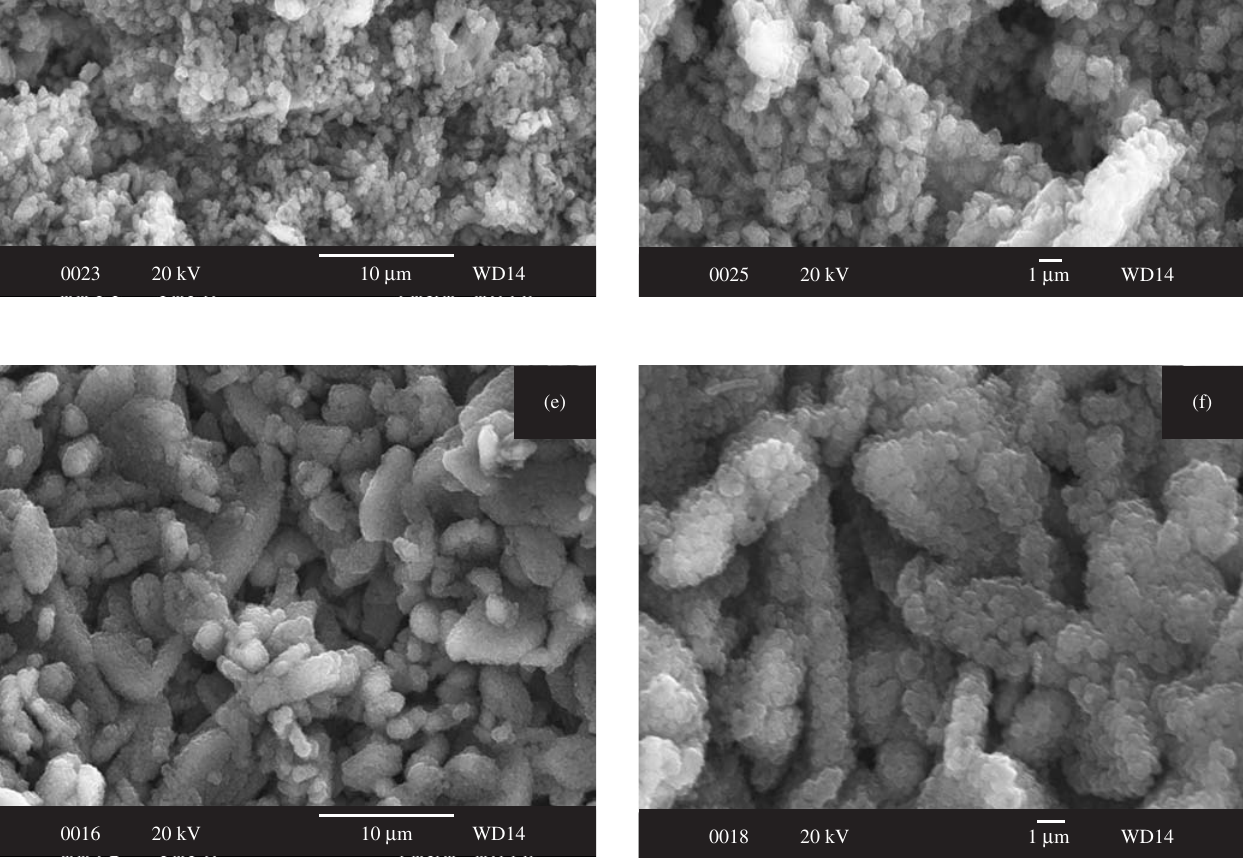
Figure 3. SEM micrographs of the external surface after sterilization. a) EtO; low magnification; b) EtO, high magnification; c) AC, low magnification; d) AC, high magnification; e) DO, low magnification; and f) DO, high